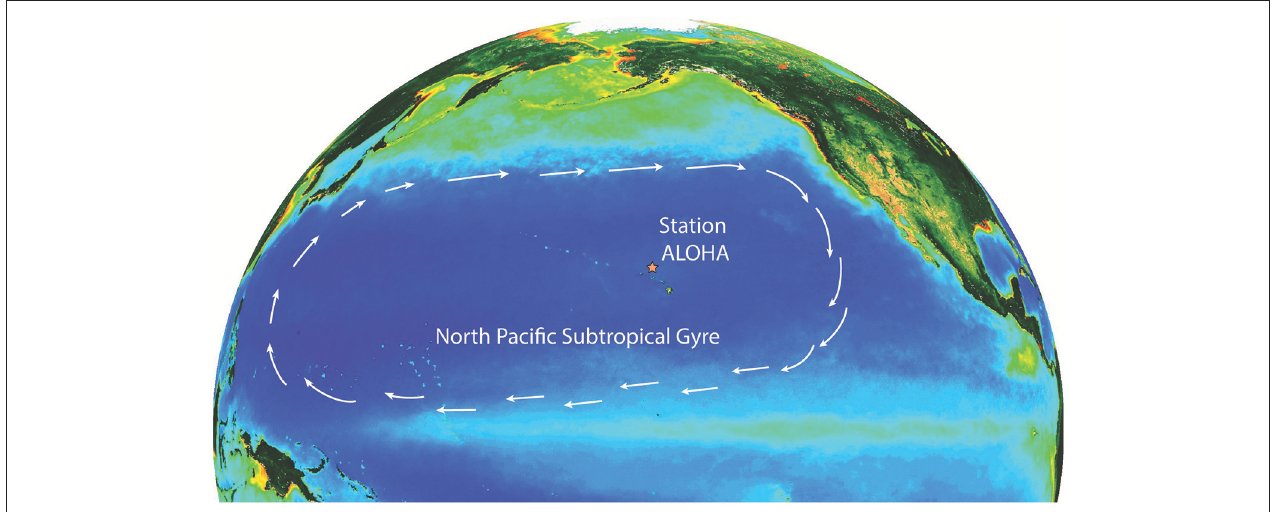
FIGURE 1 | Map of the North Pacific Ocean showing the North Pacific Subtropical Gyre and the location of Station ALOHA. The arrows depict the areal extent of the North Pacific Subtropical Gyre and show the direction of geostrophic flow. The background colors depict summer chlorophyll a distributions as determined by the